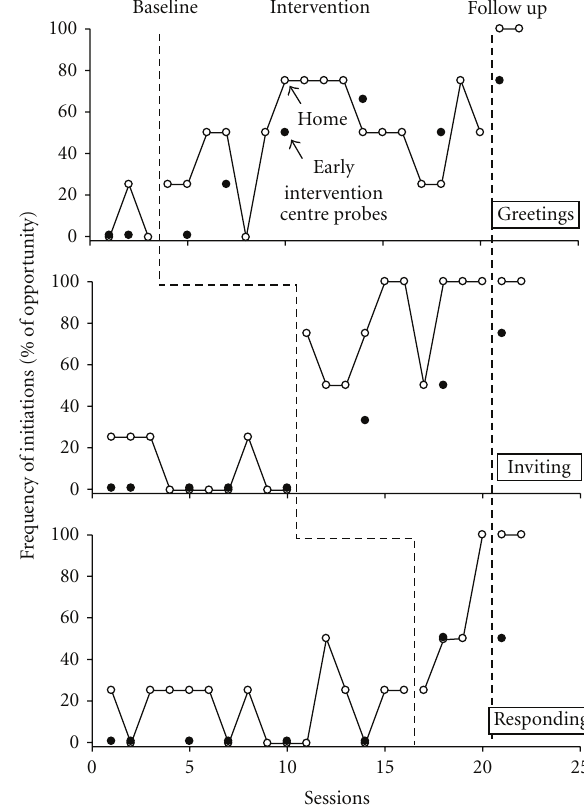
Figure 1: Frequency of scripted social initiations pre-, during and postintervention.